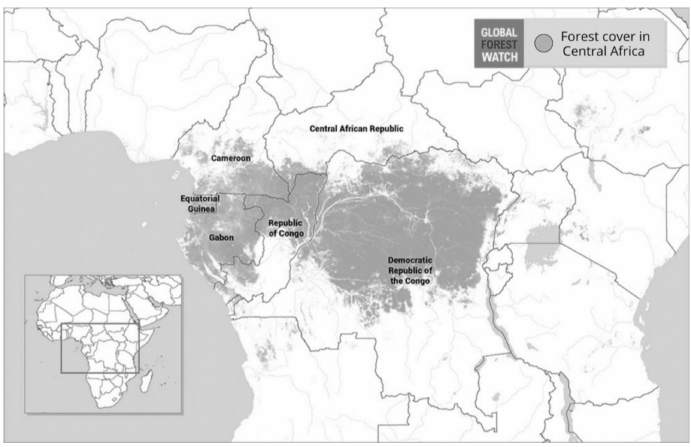
Figure 2. Map of Congo Rainforest system, Source: